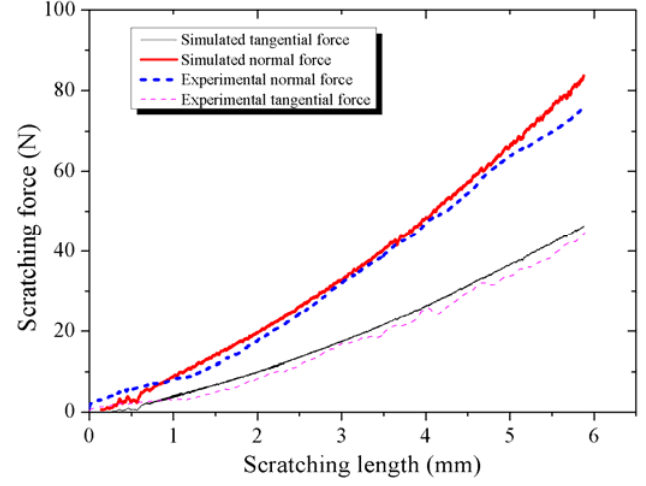
Figure 9. Comparison of the scratching forces acquired by the simulation and experiment.